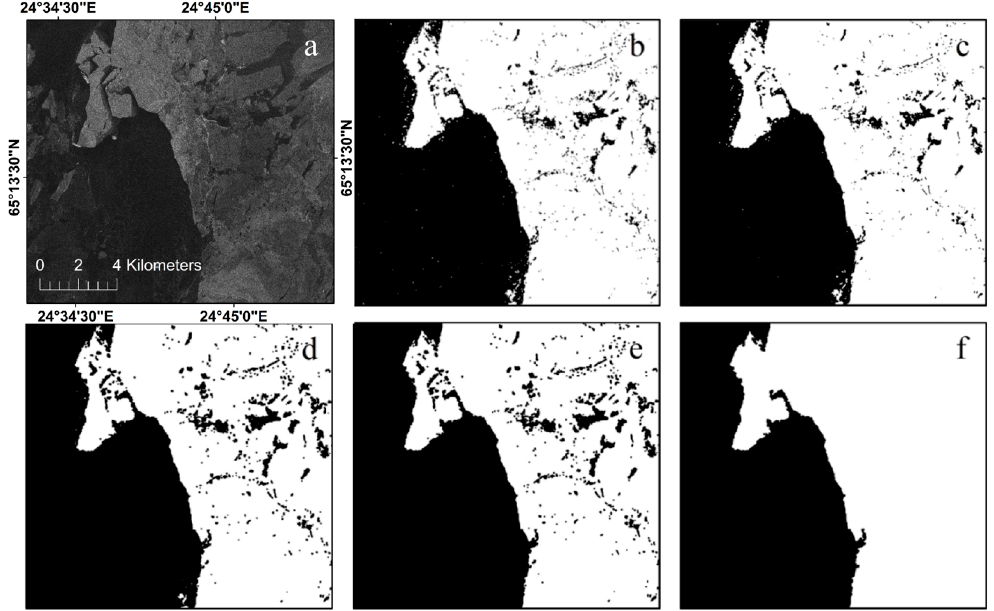
Figure 3. ( a ) The coherence image obtained from image pair 3; The process results after multiscale segmentation ( b ), median filtering ( c ), morphological erosion ( d ), rejection of small patches ( e ) and floodfill algorithm ( f ), respectively. The white area represents landfast ice, and the black area represents other ice.